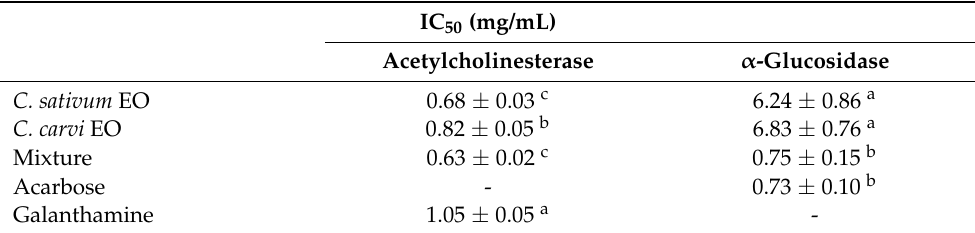
Table 7. Inhibitory activities of acetylcholinesterase and α -glucosidase of two EOs ( C. carvi and C. sativum ) and their mixture compared to authentic standards (Galanthamine,